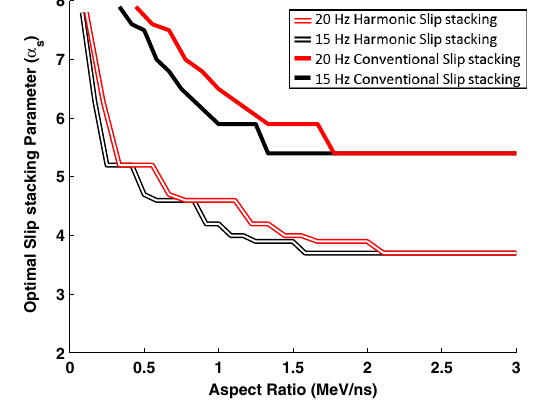
FIG. 12. Optimal slip stacking parameter α s for 99% admit- tance (at 99% efficiency) as a function of aspect ratio.